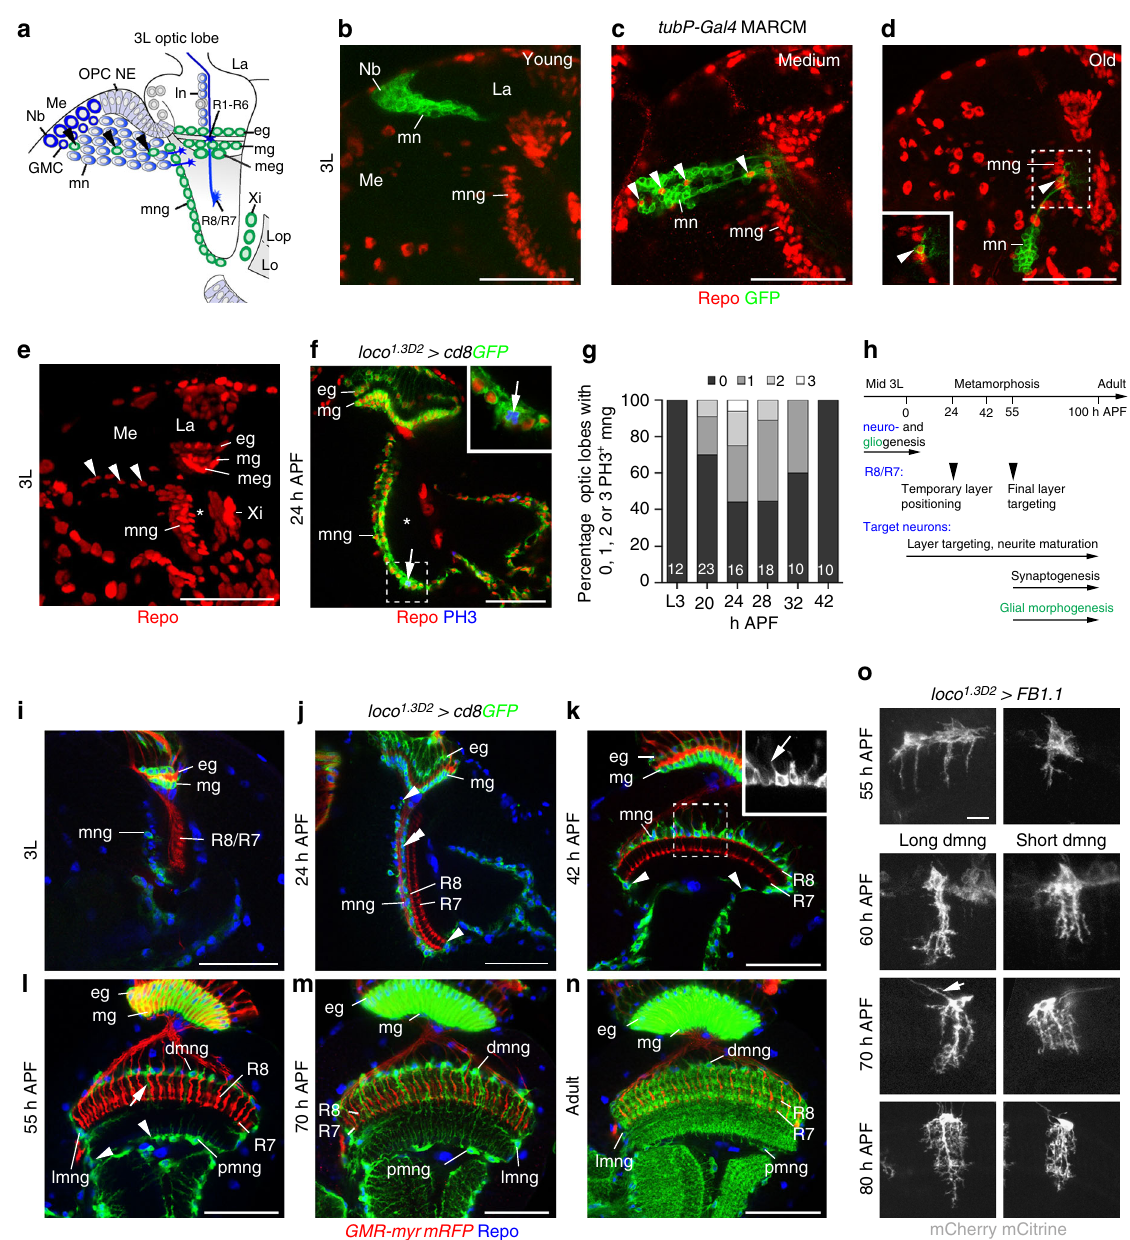
Fig. 2 Development of astrocyte-like medulla neuropil glia. a Schematic of a third instar larval (3L) optic lobe. mng medulla neuropil glia, eg epithelial glia, GMC ganglion mother cell, La lamina, Lo lobula, Lop lobula plate, ln lamina neurons, Me medulla, meg medulla glia, mg marginal glia, mn medulla neurons, Nb neuroblast/neuroglioblast, OPC NE outer proliferation center neuroepithelium, R1-R6, R8/R7 , R-cell axon subtypes, Xi inner chiasm glia. Arrowheads , migratory mng. b – d MARCM clones were generated using tubP-Gal4 and hs-FLP transgenes. Young GFP-labeled clones ( green ) closest to the OPC neuroepithelium contain Nb and neurons ( b , n = 18). Medium ( c , n = 6) and older ( d , n = 11) clones include Repo-positive glial cells ( arrowheads , red ). e A projection of optical sections illustrates the migratory path of OPC-derived mng ( arrowheads ) through the cortex toward the anterior medulla neuropil edge ( asterisk ). f In 24 h APF optic lobes, mng were labeled with loco 1.3D2 -Gal4 UAS-cd8GFP ( green ) and Repo ( red ), and cells undergoing mitosis with phosphoHistone 3 (PH3, blue ). g Percentage of optic lobes containing PH3-positive mng during early metamorphosis ( n = optic lobes: 12, 23, 16, 18, 10, and 10). h Timeline of key steps underlying R-cell, target neuron, and glial development. i – n mng were labeled with loco 1.3D2 -Gal4UAS-cd8GFP ( green ) and Repo ( blue ). During 3L ( i ), at 24 h ( j ) and 42 h APF ( k ), mng cell bodies at the neuropil border ( j , double arrowhead ) migrate around the neuropil ( j – l , arrowheads ).